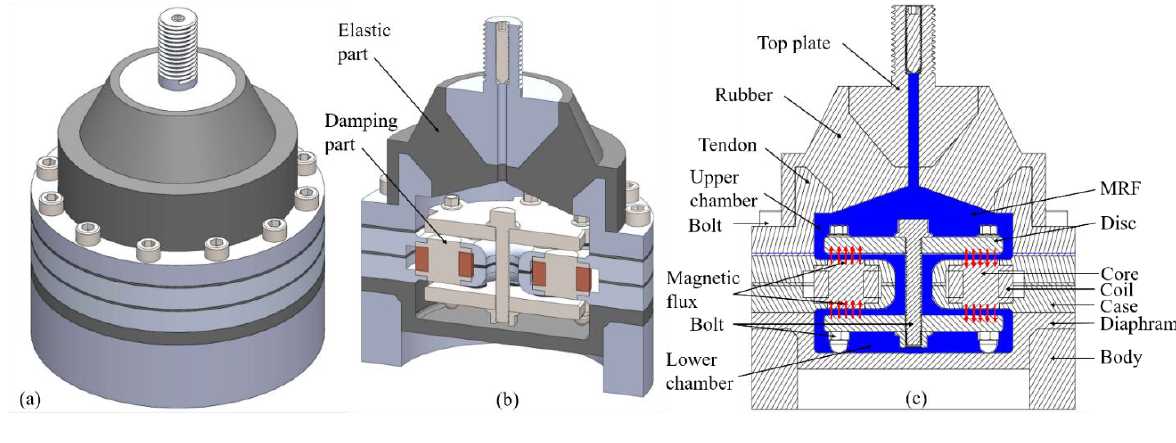
Figure 2. The proposed MR mount: ( a ) isometric view; ( b ) 3D and ( c ) 2D cross-sectional views.